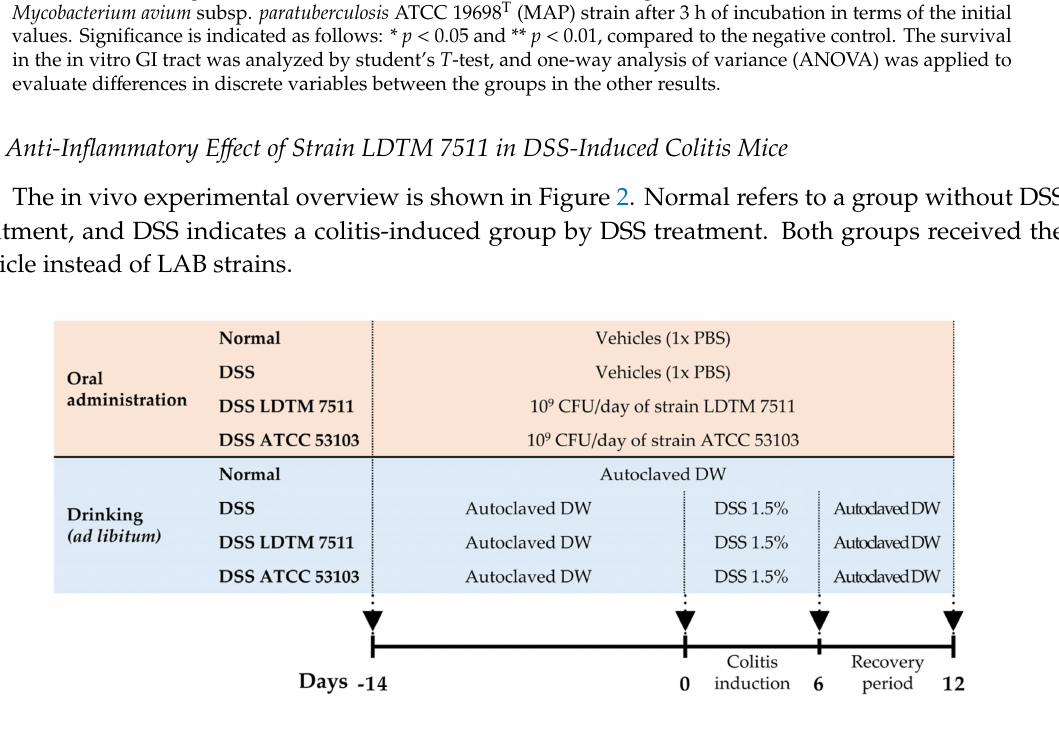
Figure 2. Overview of the in vivo experiment. Based on LAB and DSS treatment, the experimental group consisted of Normal, DSS, DSS LDTM 7511 and DSS ATCC